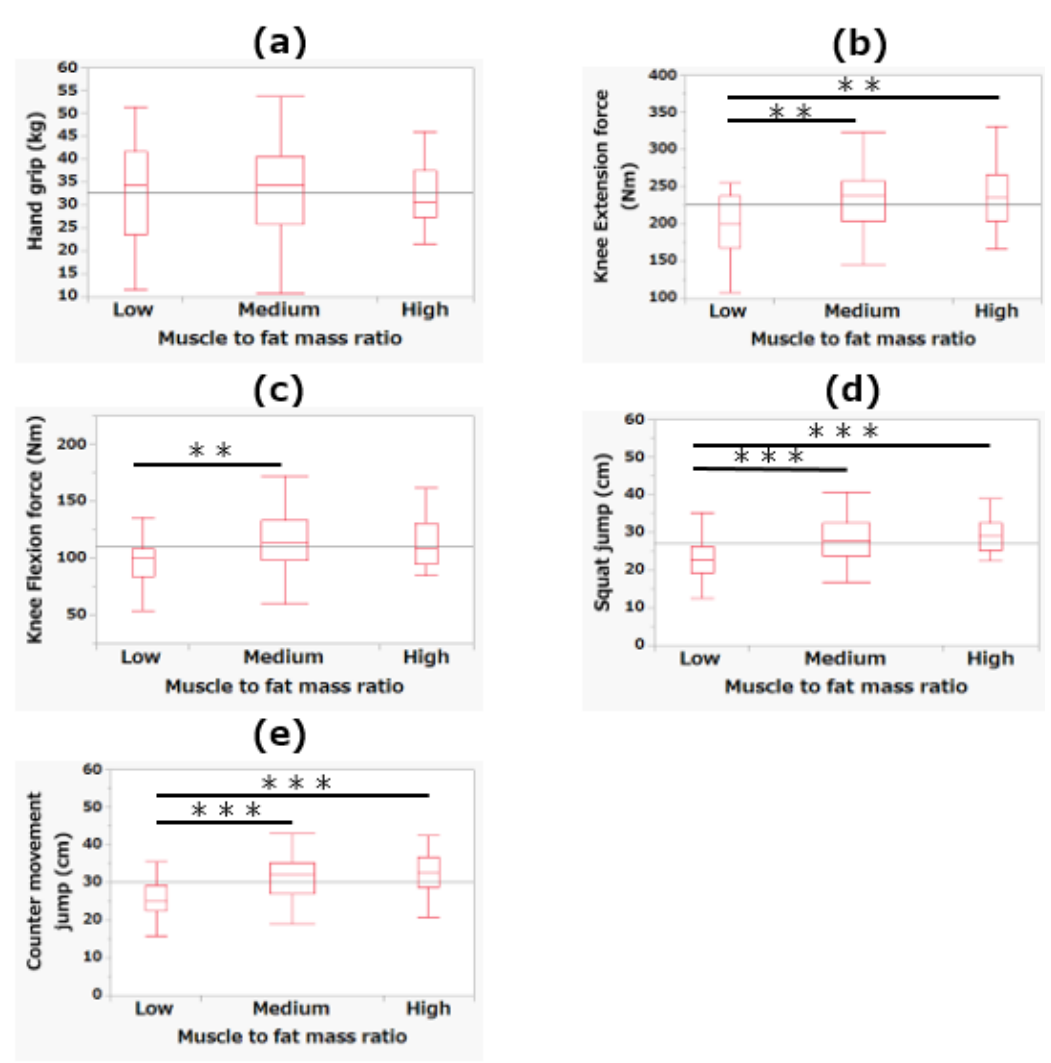
Figure 3. The differences among the tertiles of muscle-to-fat mass ratio in hand grip ( a ), knee extension force ( b ), knee flexion force ( c ), squat jump ( d ), and counter movement jump ( e ). ** p < 0.01; *** p < 0.001.